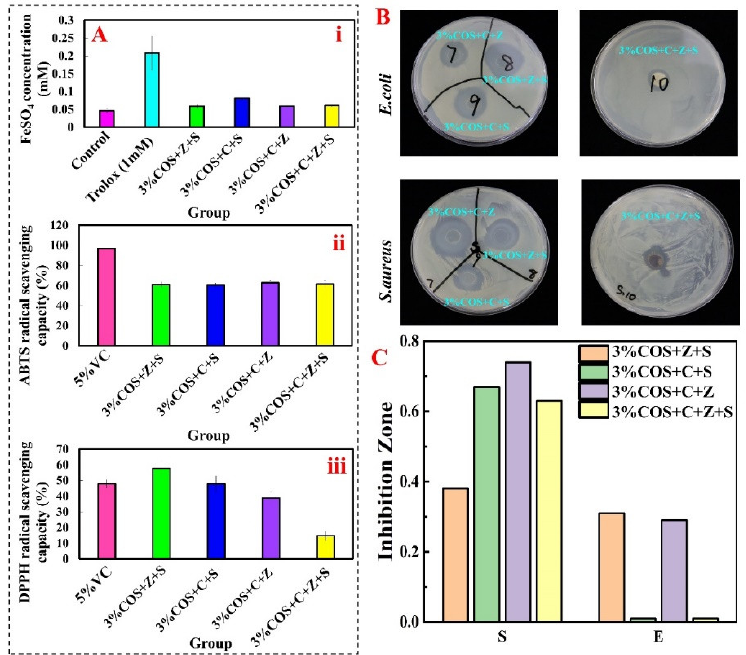
Figure 3. Activity evaluation of nIon 2+ − COS/SA gel films in vitro. ( A ) In vitro antioxidant perfor- mance evaluation of nIon 2+ − COS/SA gel films. From top to bottom, they are Fe 2+ chelating activity (i), DPPH radical scavenging activity (ii), and ABTS radical scavenging activity (iii). ( B ) Physical diagram of the inhibition circle of nIon 2+ − COS/SA gel films. ( C ) Histogram of the inhibition circle of nIon 2+ − COS/SA gel